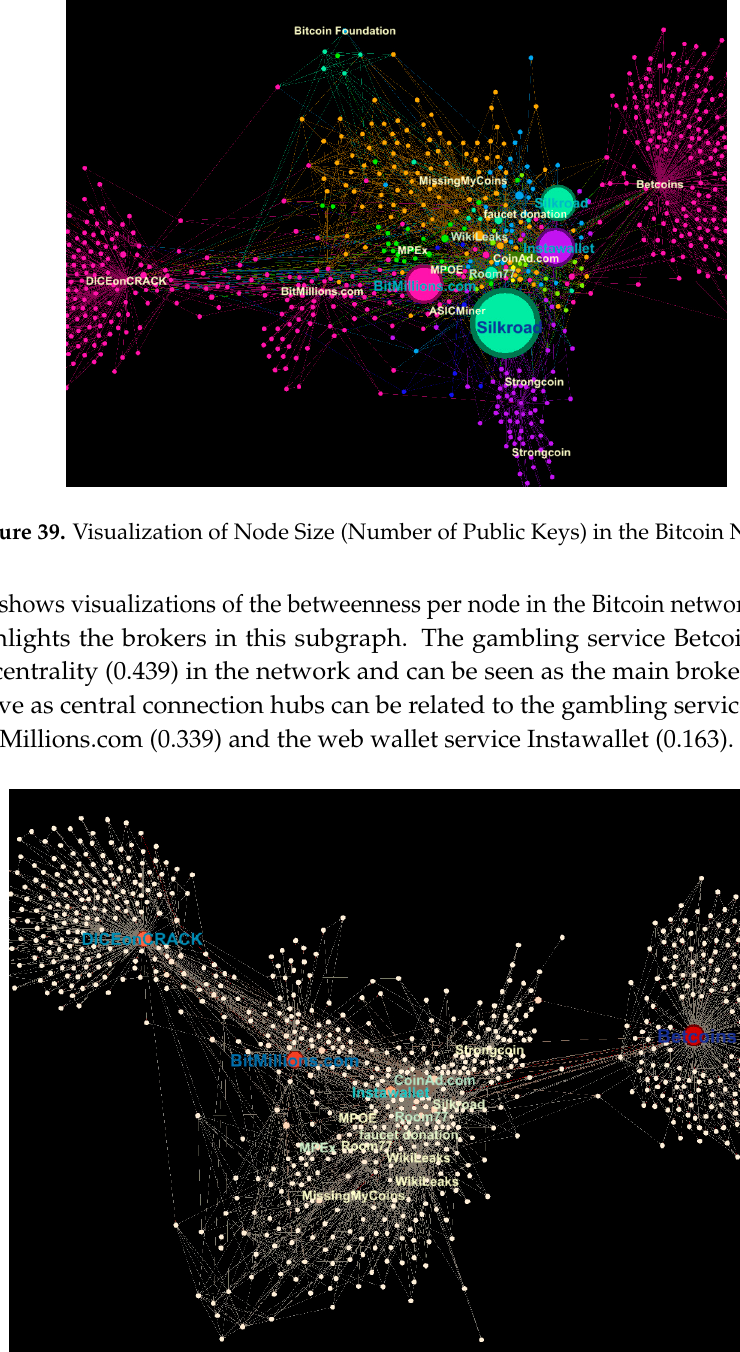
Figure 41. Closeness Centrality in the Bitcoin Network. The visualization of closeness centrality (Figure 41) shows the most central nodes in the subgraph from where Bitcoins are transacted efficiently. One can see that a large portion of the nodes related to the wallet business Strongcoin have the highest closeness centrality. The well ‐ known media/news site WikiLeaks, the vendor Silkroad, and the donation service Bitcoin Foundation are also very central in the network. The final visualization in Figure 42 shows the Bitcoin network with geo ‐ located nodes. Nodes are colored by country (and edges by the source node). For this analysis, only nodes that transact via one IP address can be considered; thus, this subgraph (tagged as Business, excluding SatoshiDICE,